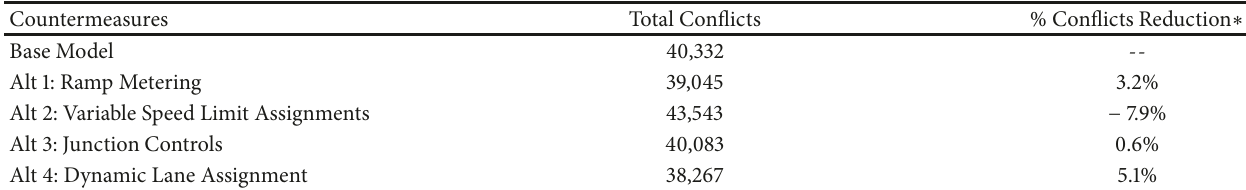
Table 4: Conflict reduction percentage after implementation of ITS countermeasures.